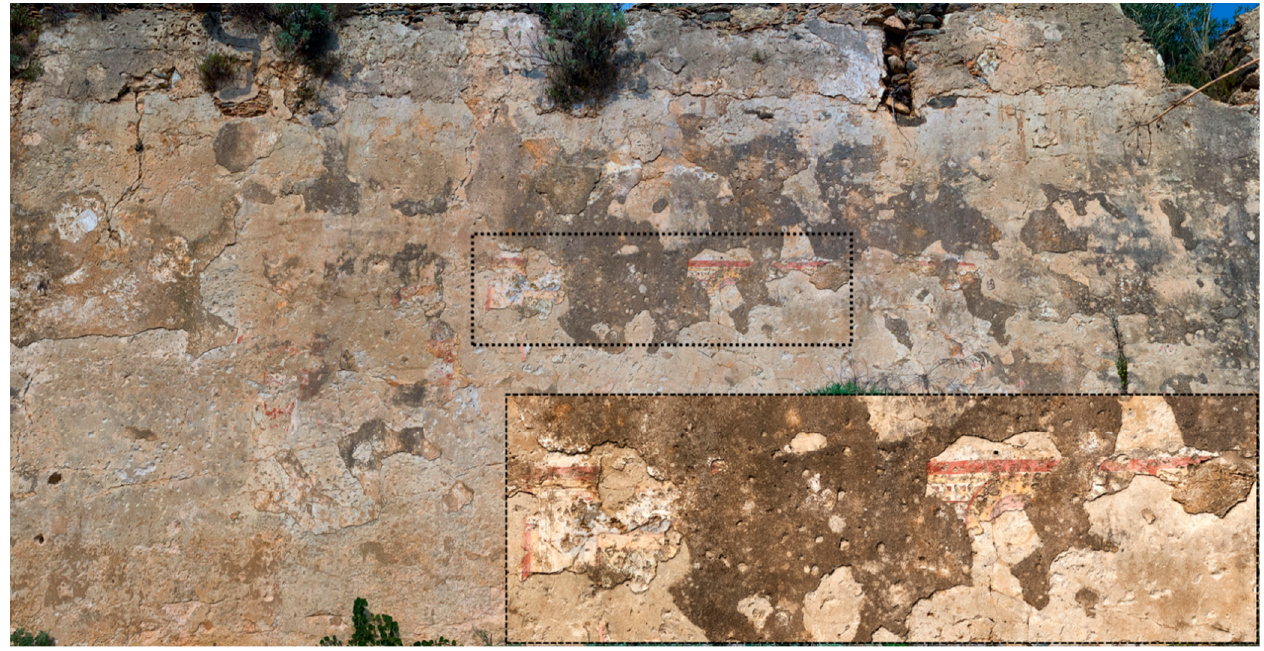
Figure 8. Detail of the fresco visible along the left wall of the nave (orthophoto by